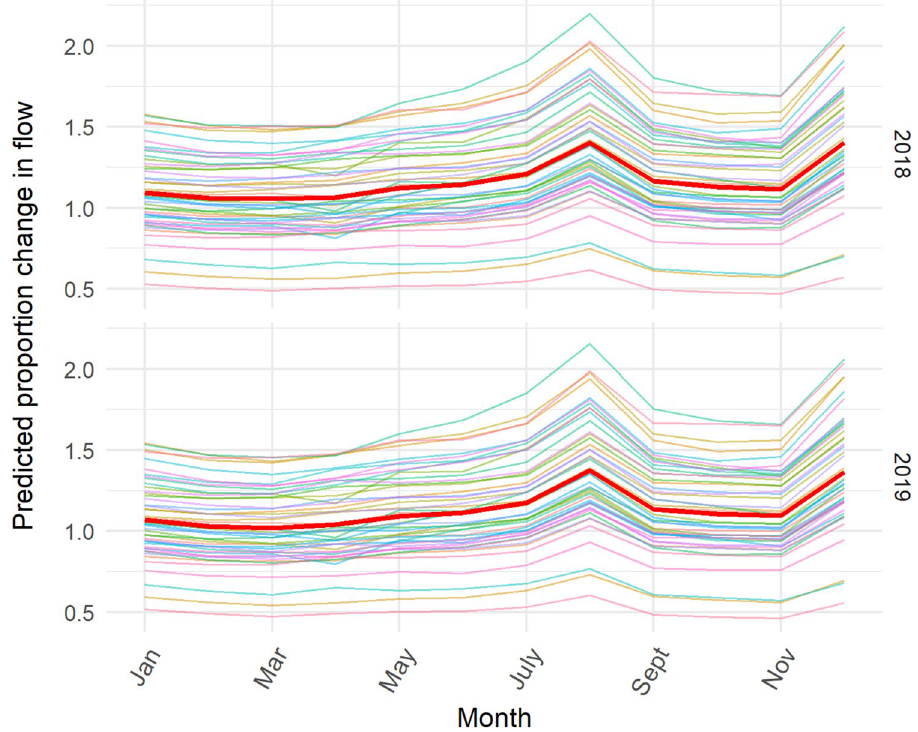
Figure 6. Modelled monthly mobility flows for 2018 and 2019, as compared to the baseline mobility flow for January. Coloured lines represent seasonal mobility patterns for each county within Kenya, and the red line represents the average seasonal mobility pattern for all counties over the